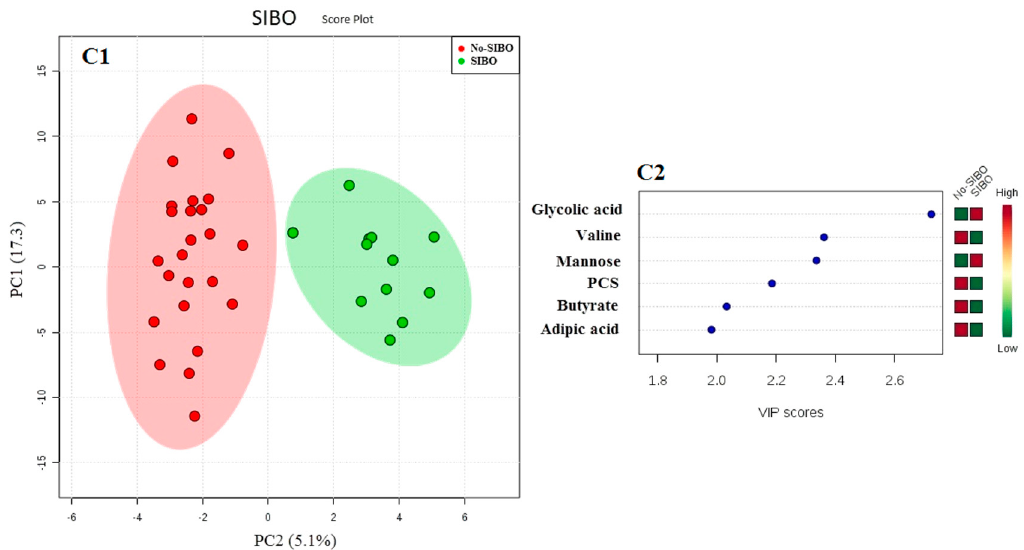
Figure 1. Partial least square discriminant analysis (PLS-DA) models to discriminate children according to Body Mass Index (BMI) ± Non-Alcoholic Fatty Liver Disease (NAFLD) ( A1 ); NAFLD ( B1 ), and Small Intestinal Bacterial Overgrowth (SIBO) ( C1 ) as unique parameters investigated. The explained variance of each component is shown in brackets on the corresponding axis. In panel ( A1 ), blue circles represent the obese children with NAFLD (OB[NAFLD+]), green circles represent obese children without NAFLD (OB[NAFLD − ]), while red circles represent the normal weight controls (NW). In panel ( B1 ), red ellipse contains NAFLD negative obese children, while green one the NAFLD positive obese children. In panel ( A3 ), red ellipse contains SIBO negative children, while green the SIBO positive children. The first 14, 9, and 6 VIP variables identified by the corresponding PLS-DA are shown in Panels ( A2 ), ( B2 ) and ( C2 ), respectively. The number of VIPs was established by setting the VIP-score ≥ 2 as a cut off value. In panel ( A2 ) one VIP was not identified because its mass spectrum did not reach the predefined library comparison performance (in terms of similar index or Kovats index difference). In all cases, the colored boxes on the right indicate the relative amount of the corresponding metabolite in each group under study.